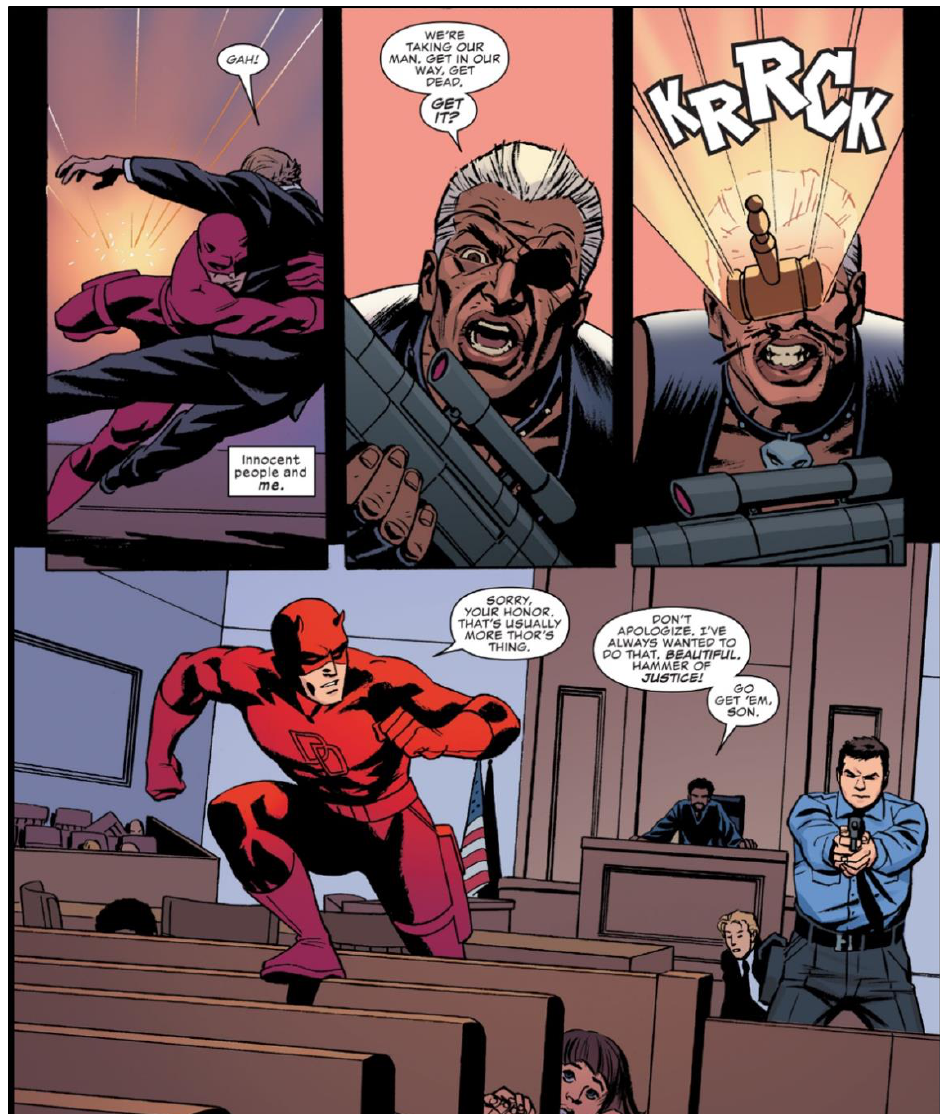
Figure 9. Page from Soule’s Daredevil: Back in Black Vol. 5: Supreme #22, 2017 Image Credit: Goran Sudžuka © 2017 Marvel Characters,